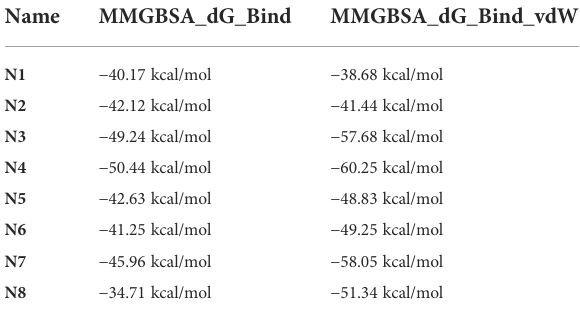
Table 3 for comparison. We found an exciting revelation that the proportion of molecules fi ltered by the af fi nity model with